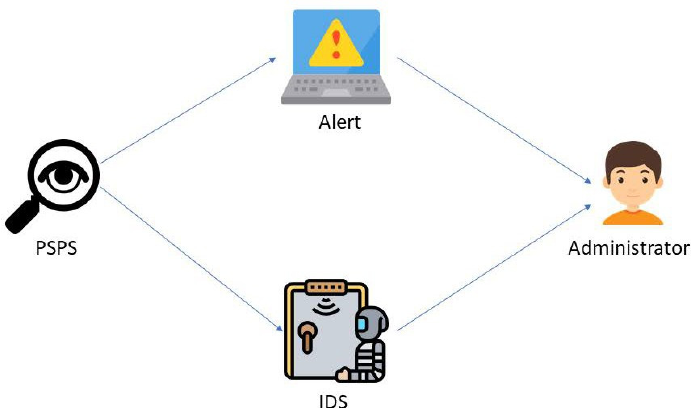
Figure 2. PSPS prototype: PSPS sends an alert message to the administrator directly. Alternatively, the alert message is returned by PSPS. It can be used as an input to traditional IDS in order to handle different types of intrusion.